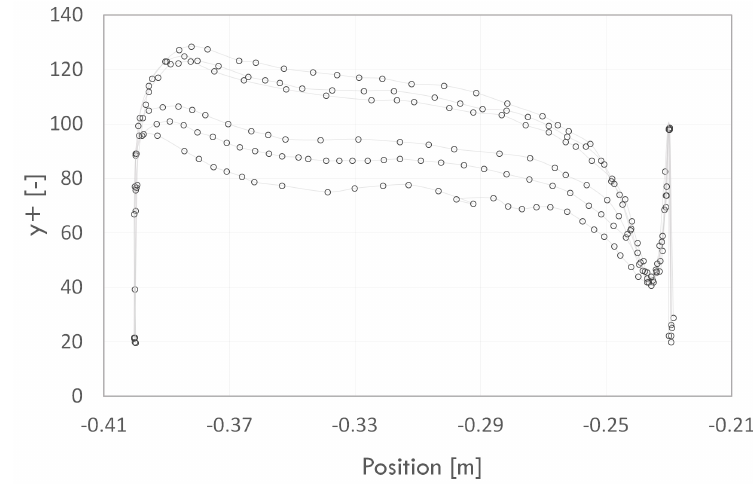
Figure 12. Value of the y+ parameter along the length of the heat sink.